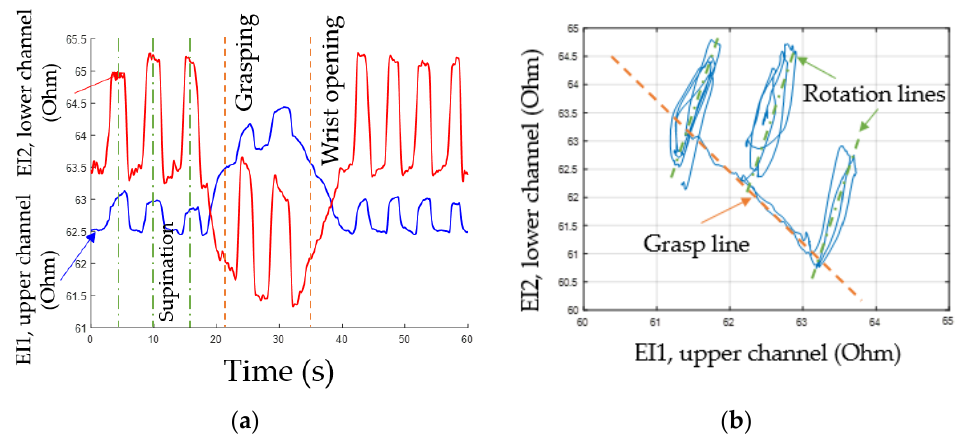
Figure 9. Analysis of EI signals: ( a ) experimental signal data during movements, ( b ) phase diagram.